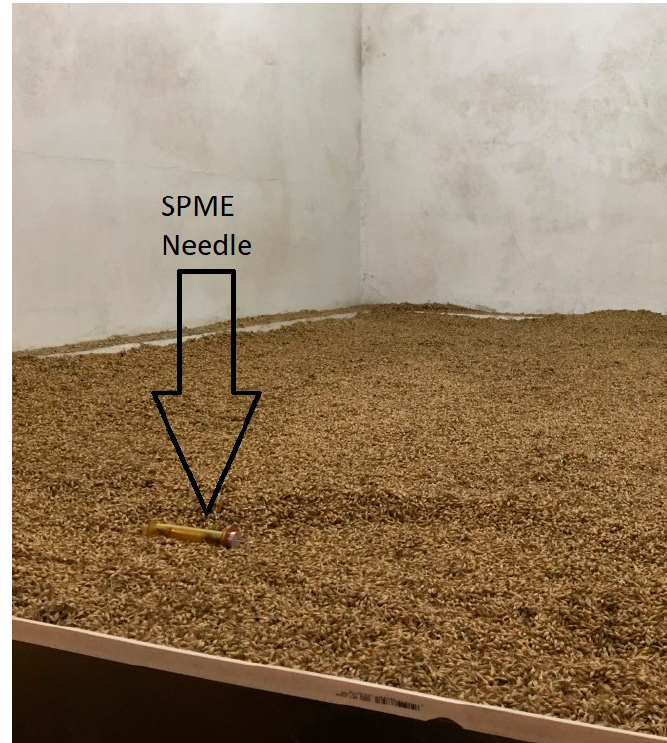
Figure 1. Solid Phase Microextraction (SPME) needle positioned on top of the grain bed in the kiln.